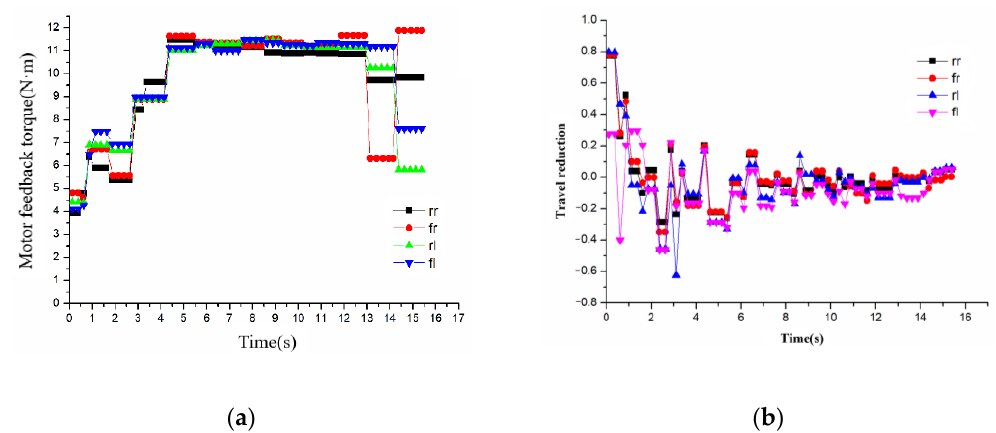
Figure 9. Motor feedback torque and travel reduction of non-controlled strategy.( a ) Motor feedback torque; ( b ) Travel reduction.